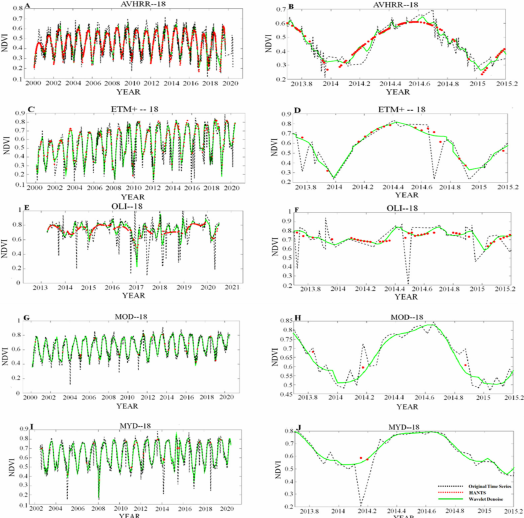
Figure 4. Example of original NDVI time series, HANTS, and WTD algorithm implemented for reconstruction and denoising of five different NDVI datasets in the sample point 18 (73.7667E, 33.8667N), in tree cover, broadleaved, and evergreen landcover. ( A ) AVHRR NDVI time series during 2000–2020 (dashed black line) and its HANTS (red dots) and WTD results (green line). ( B ) Highlights the AVHRR NDVI modeling behavior in specific timespan (2013–2015). ( C – J ) diagrams represents similar information on ETM+, OLI, MOD, and MYD, respectively (OLI mission starts in